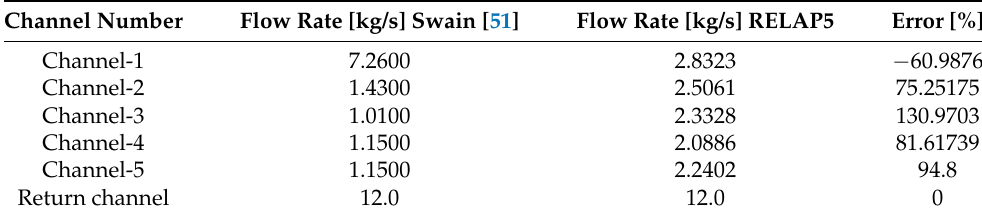
Figure 11. Pressure drop trend along the specified fluid path, for Ha = 17,845 and N = 4697. Table 10. Mass flow rate outcomes for MHD ( B = 4 T ), comparison between CFD analysis and